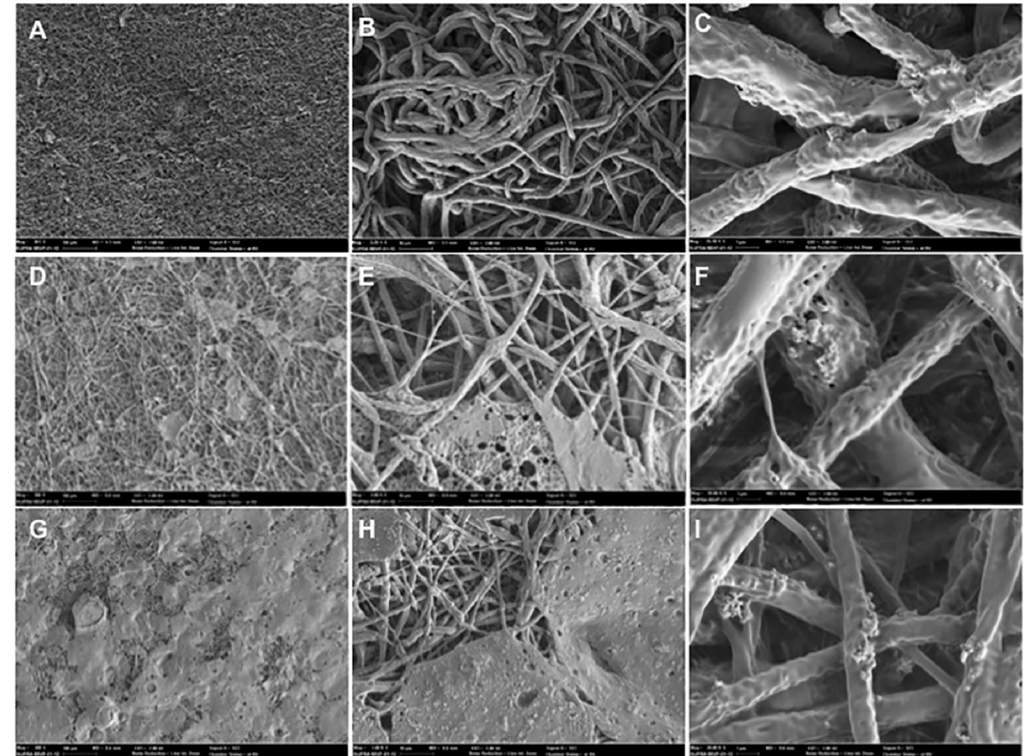
Figure 2. Scanning electron microscopy (SEM) micrographs of the membrane surface at 300× magnification, scale bar = 100 µm ( A, D and G ); 3000× magnification, scale bar = 10 µm ( B, E and H ); 20000× magnification, scale bar = 1 µm ( C, F and I ). A, B and C (200 µm membrane), D, E and F (500 µm membrane), and G, H and I (700 µm membrane). Materials 2019 , 12 , x FOR PEER REVIEW